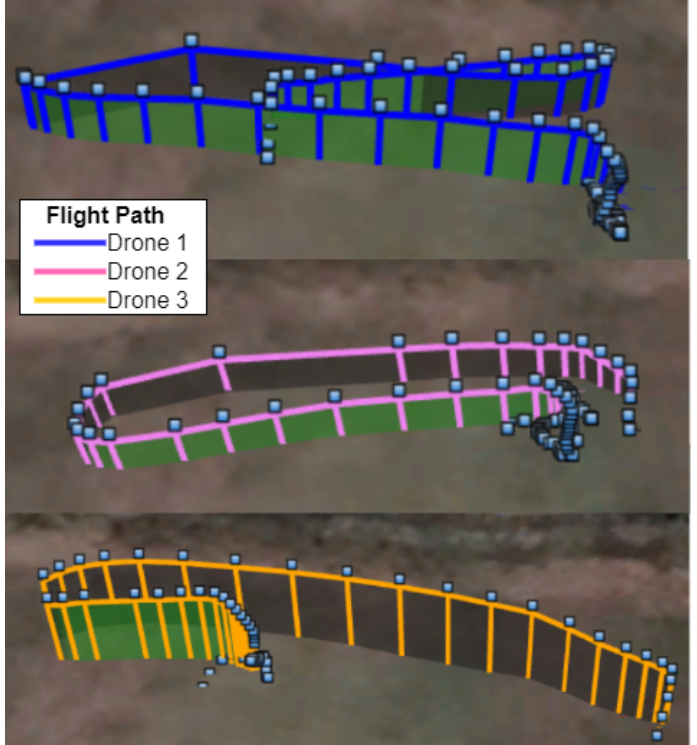
Figure 15. Individual drone flight paths were logged during the test flight and depicted using the Google Earth application.